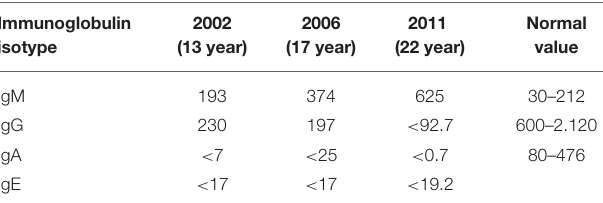
TABLE 2 | The patient’s serum immunoglobulin levels (mg/dL) over the